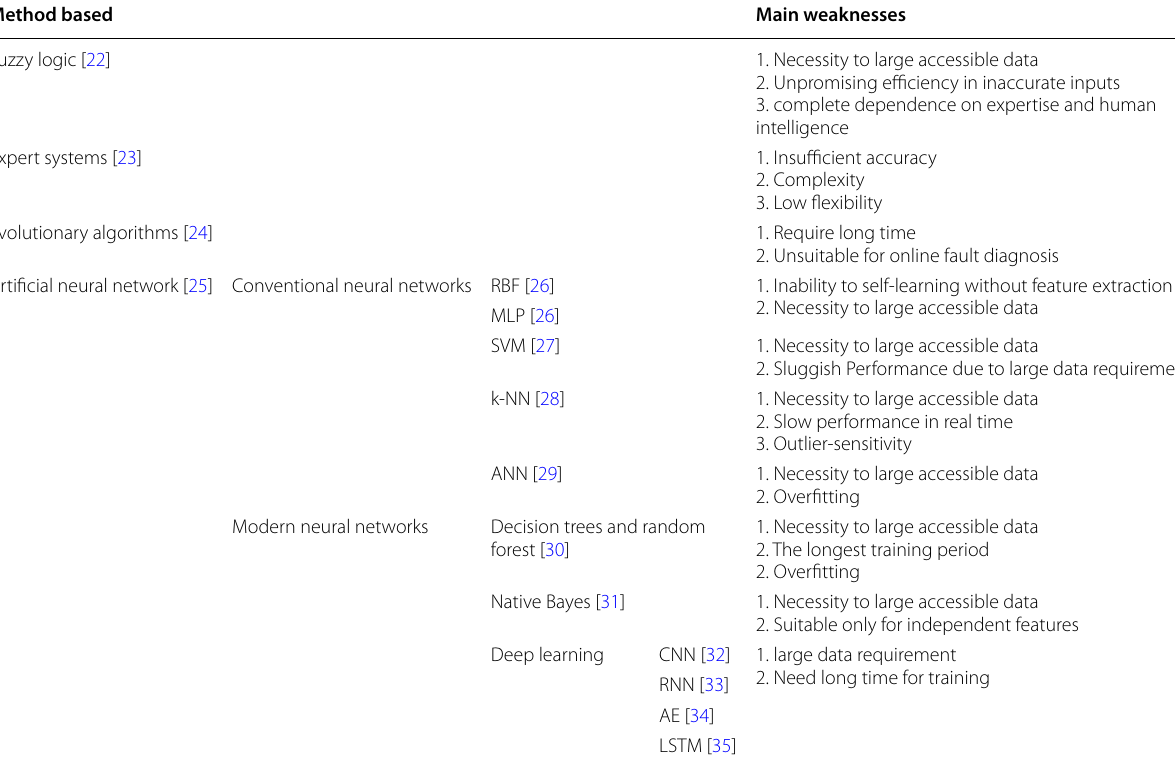
Table 1 The categorization of artificial intelligence-based methods Method